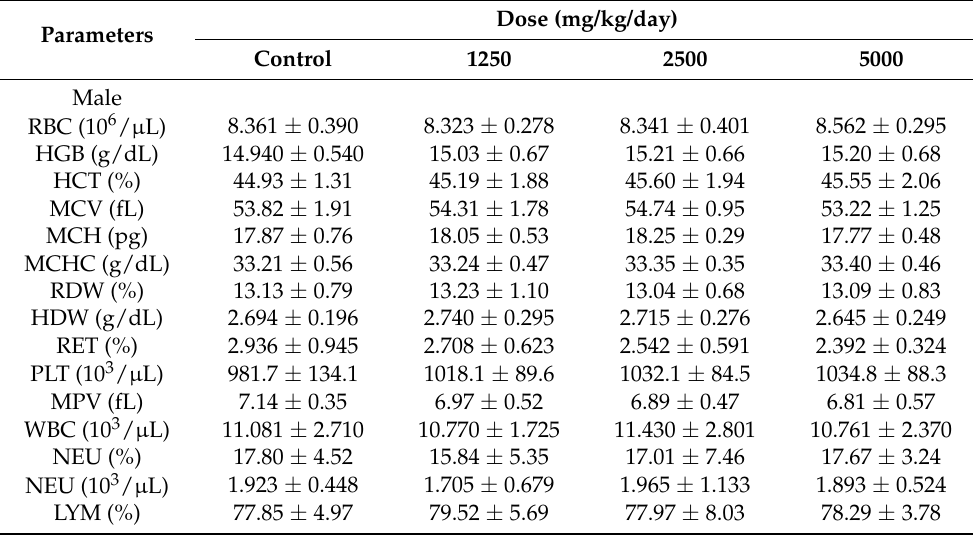
Table 7. Hematology values in 13 weeks repeated oral dose toxicity of WG extract in male rats.